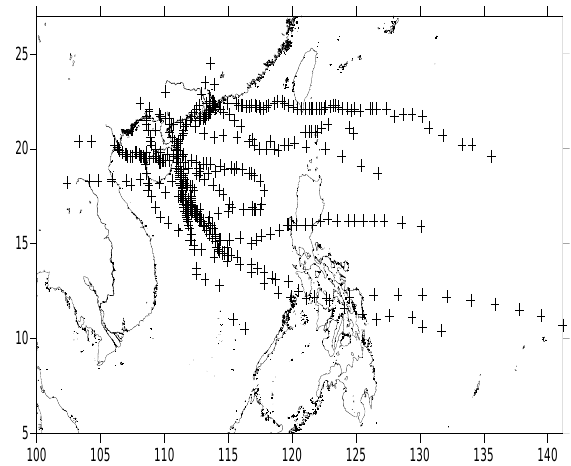
Figure 9. Pathway of typhoons affecting Xincun Bay since